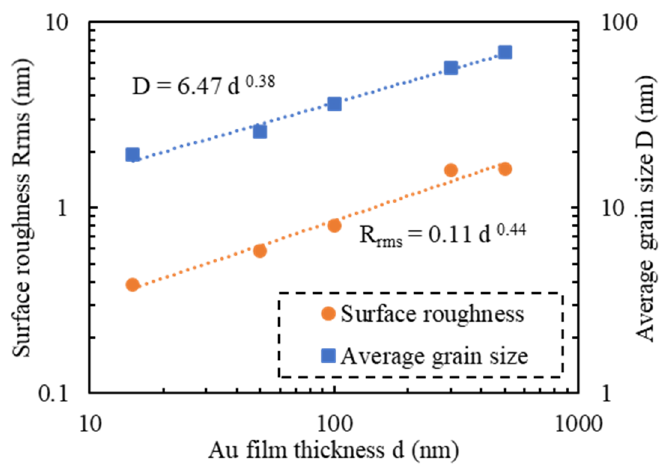
Figure 4. Effect of thickness of Au films deposited on Si wafers on surface roughness and average grain size.